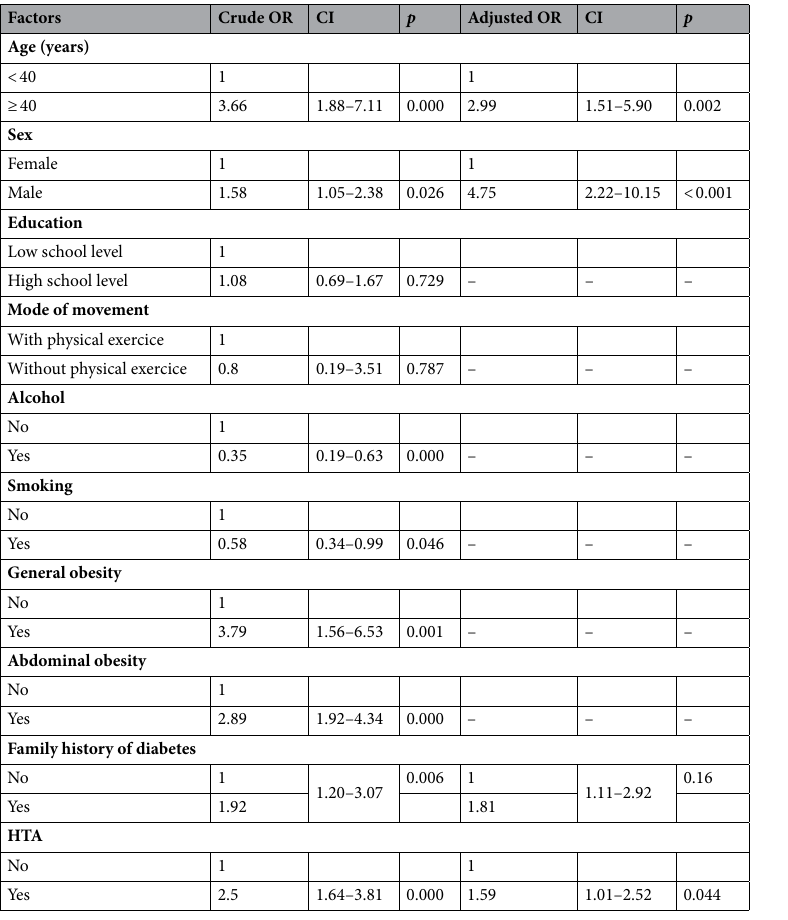
Table 5. Risk factors for diabetes in the population of Gombe